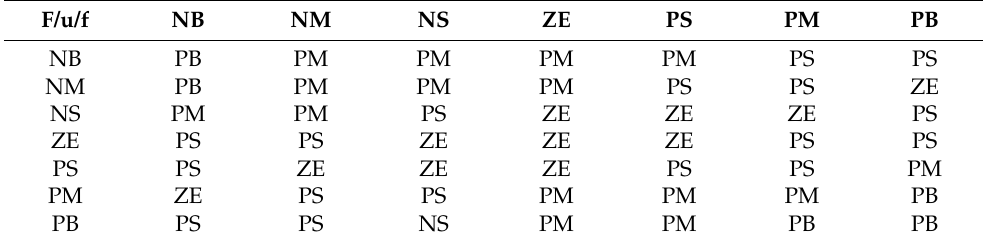
Table 2. Fuzzy rules of ∆ k p .